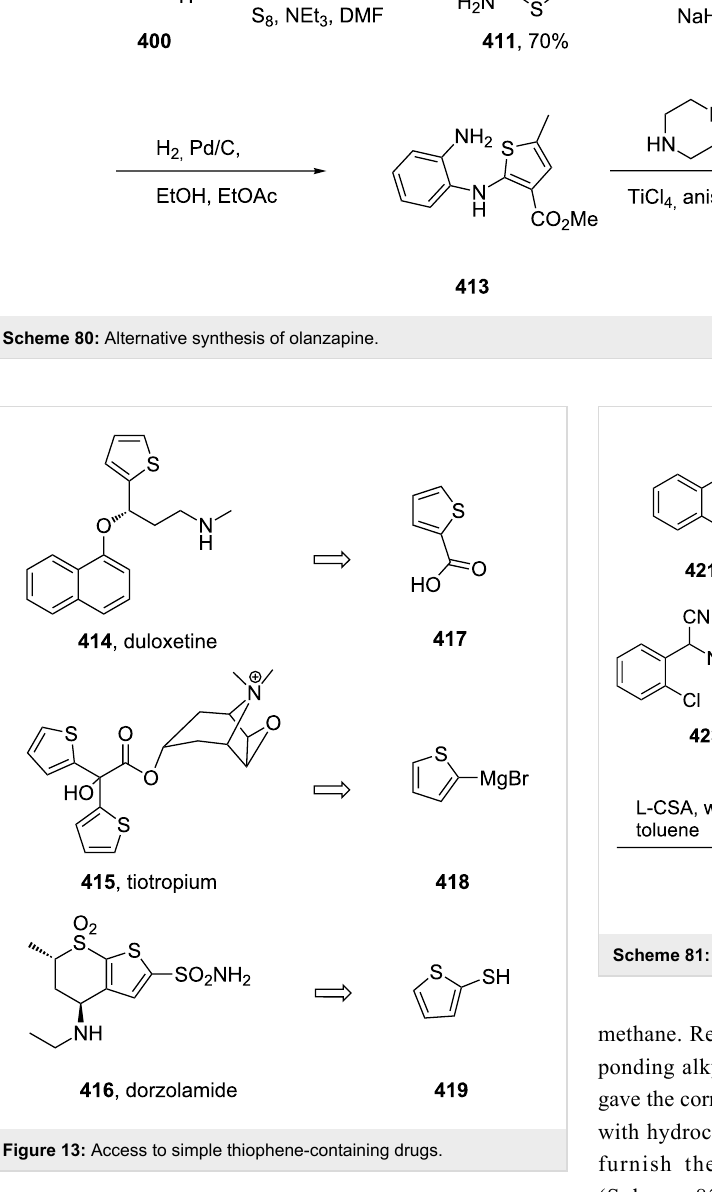
(L-CSA) in toluene is used. The desired enantiomer 420 is collected as a crystalline salt in greater than 98% ee and 88% of the expected yield (Scheme 81) [126]. The remaining material can be easily epimerised under mildly basic conditions.